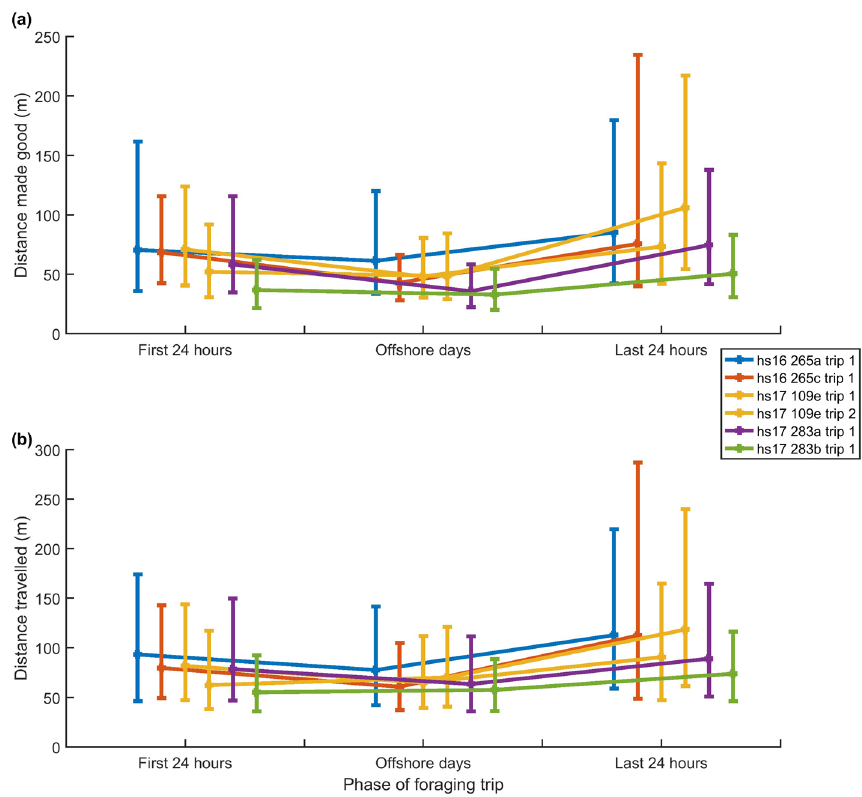
Figure 5. ( a ) Median distance made good between successive PCA locations over each phase of the foraging trip. ( b ) Median distance travelled between successive PCA locations over each phase of the foraging trip. Error bars in both plots represent lower and upper